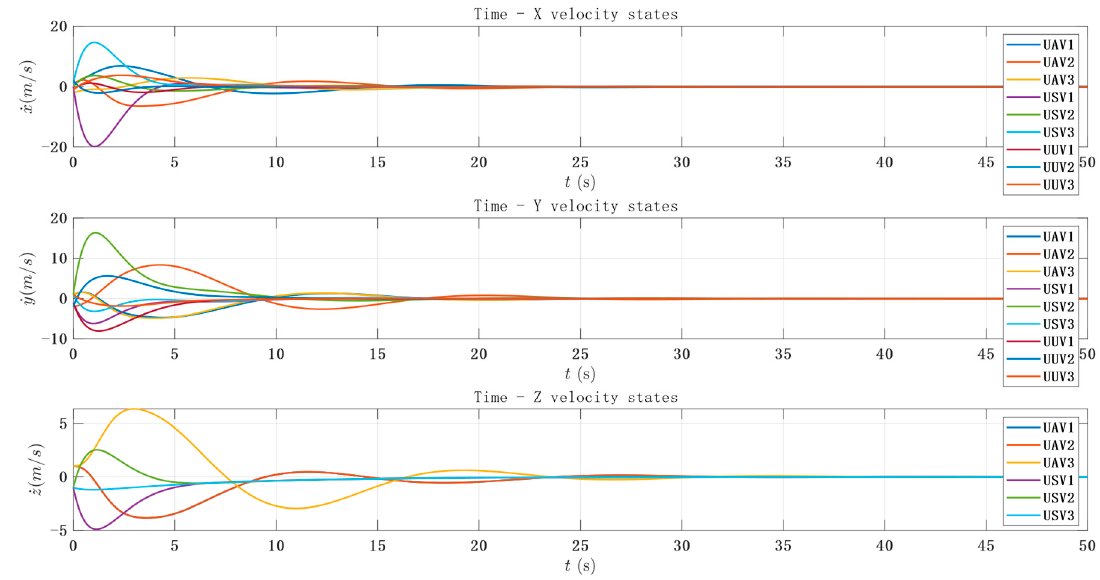
Figure 5. Velocity state with static formation control.